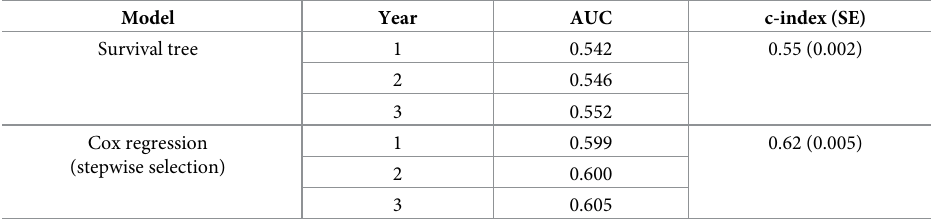
Table 5. Comparison of model fits (by 10-fold cross-validation) to predict the injury recurrence using survival time-to-event and censoring